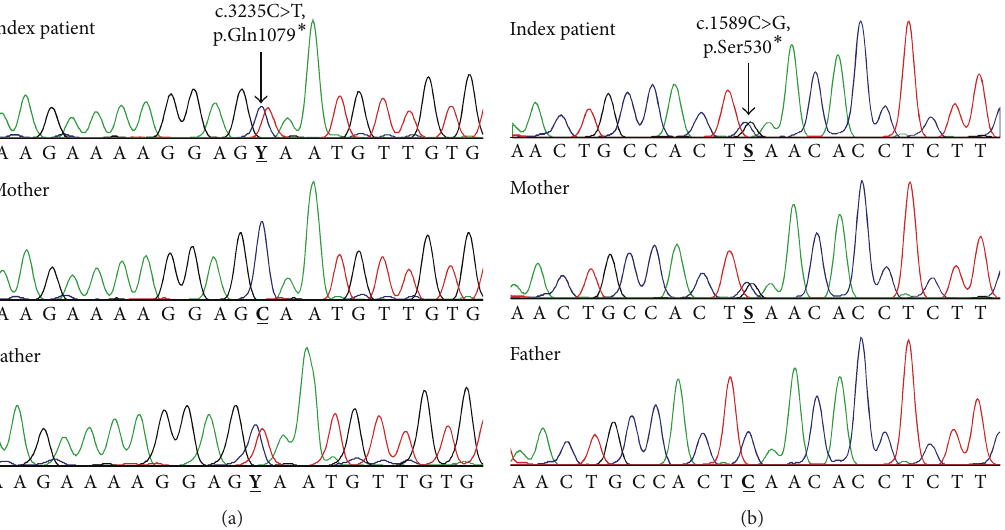
Figure 1: Sequence analysis of the index patient showing the novel mutation c.3235C > T, p.Gln107 9 ∗ in exon 24 (a) and the known mutation c.1589C > G, p.Ser53 0 ∗ in exon 12 (b).